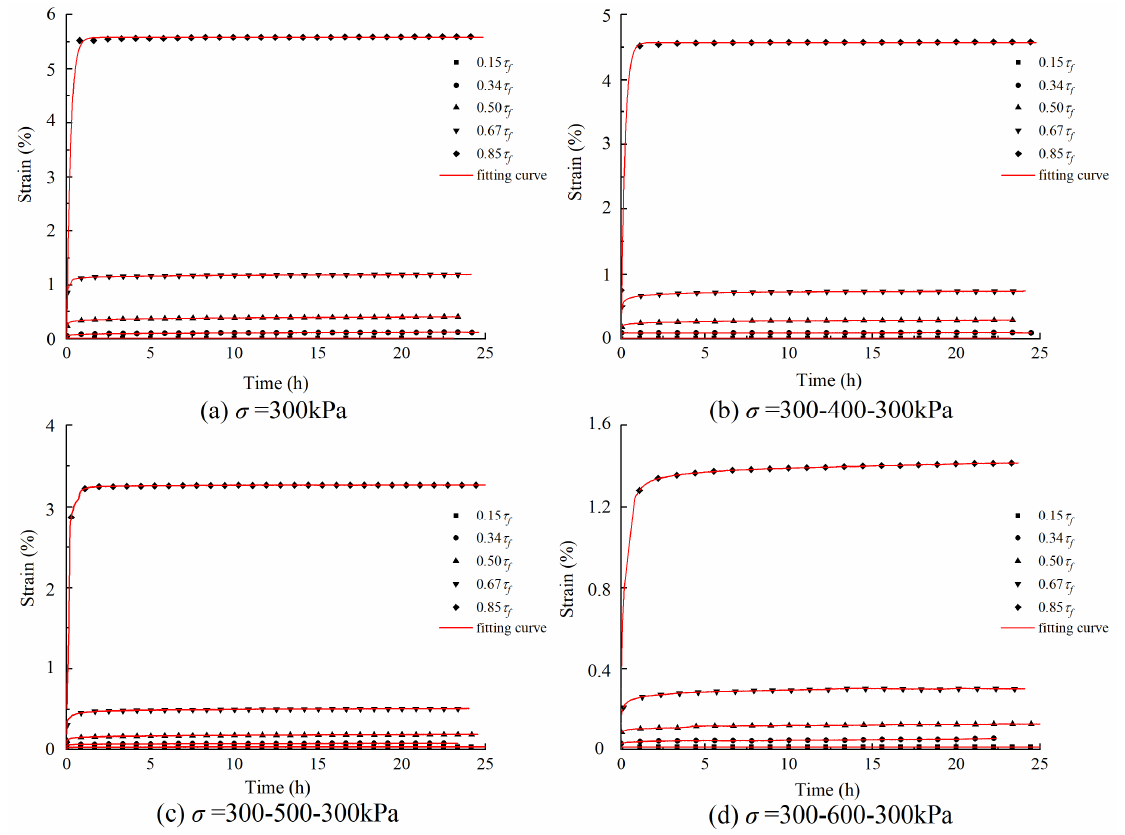
Figure 13. Comparison between the fitting curve and the experimental data. Table 2. Burgers constitutive model parameters.